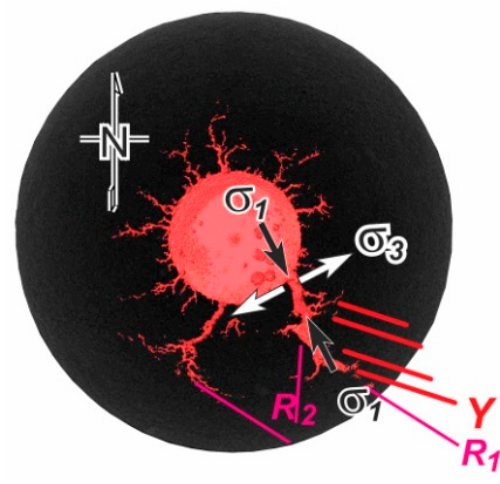
Figure 10. Results of structural interpretation of the dissolution network/wormhole morphology for experiment #6 (24 h CO 2 -rich solution injection into the sample).